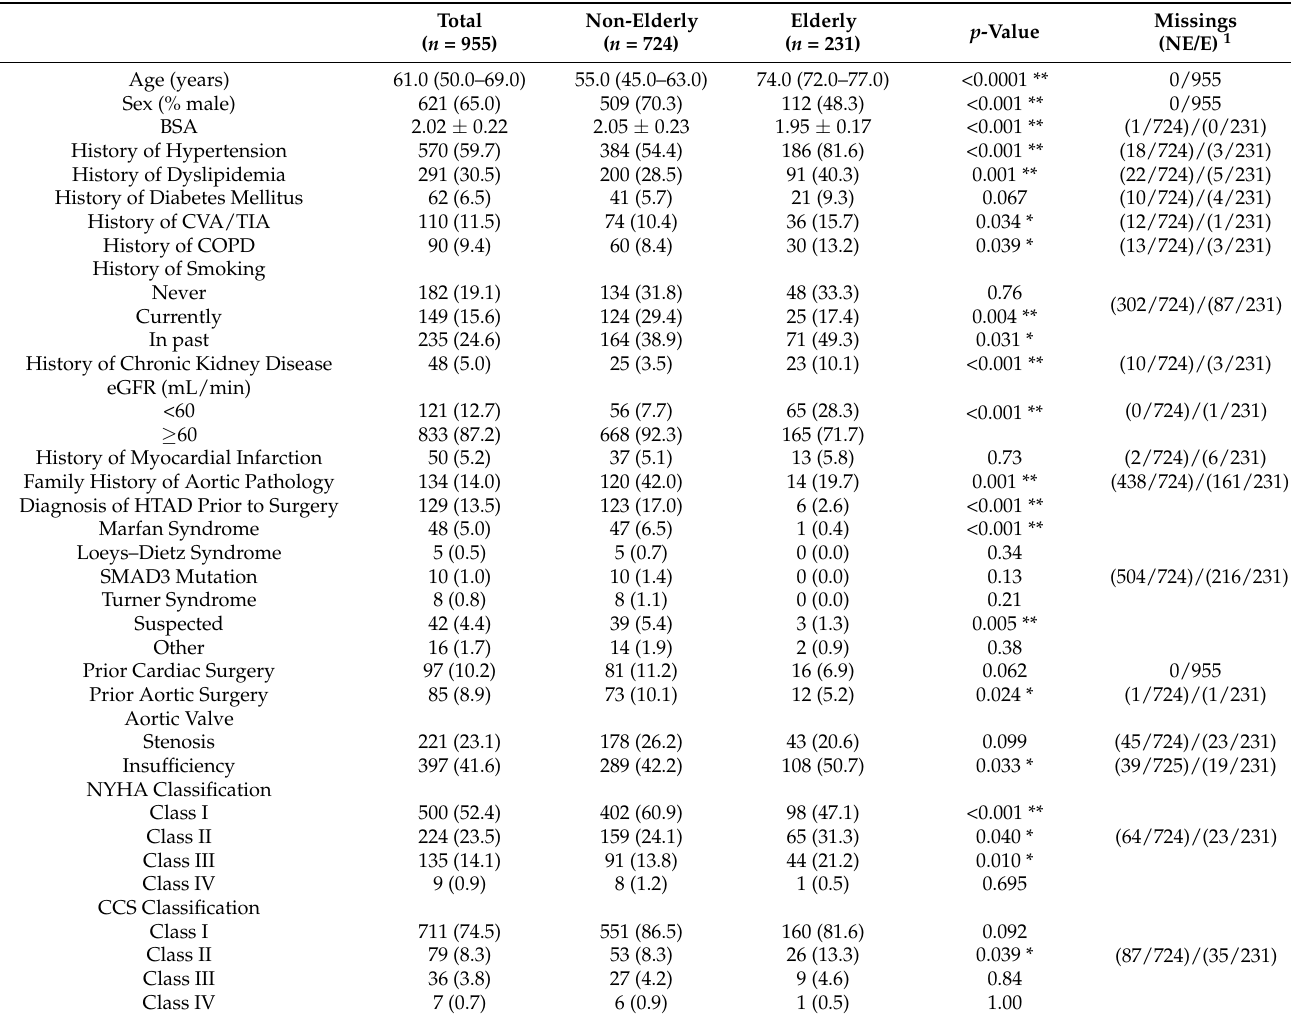
Table 1. Patient